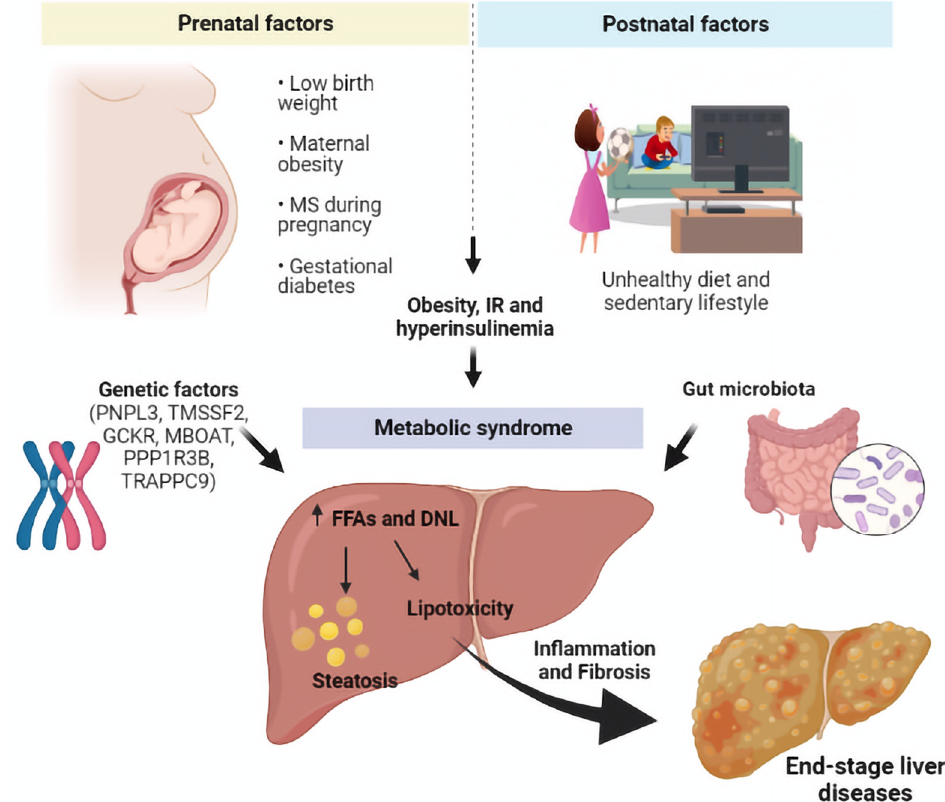
Figure 3. The role of prenatal and postnatal factors in MAFLD.